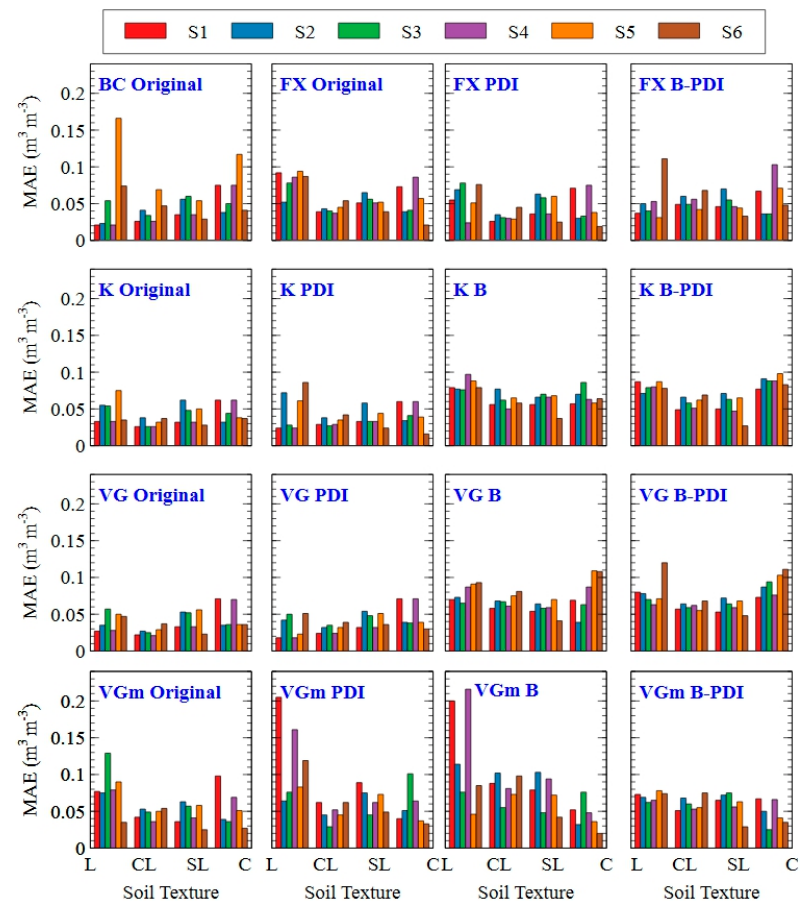
Figure 4. Performance of the 16 models for 4 textures and the six modeling scenarios (S1–S6). BC: Brooks and Corey [34], FX: Fredlund and Xing [35], K: Kosugi [36], VG and VG m : van Genuchten [24] constrained and unconstrained unimodal models. PDI and b denote Peters–Durner–Iden [30,31] and bimodal variants of the models, respectively. L: Loam (1087 data pairs), CL: Clay Loam (1277 data pairs), SL: Silt Loam (1348 data pairs), C: Clay (3708 data pairs). MBE: mean bias error (cm 3 cm − 3 ).